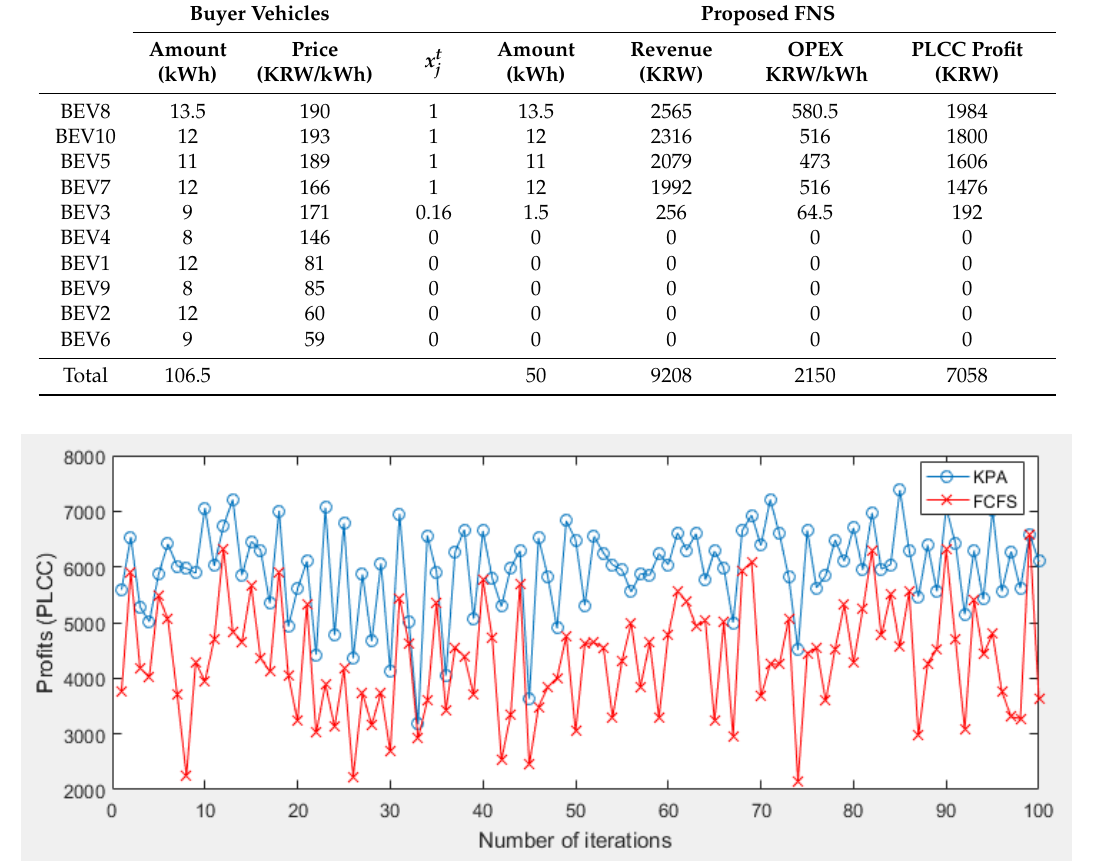
Table 9. Case (2) with KPA scheme for electric vehicles as buyers and the PLCC as a seller. Buyer Vehicles